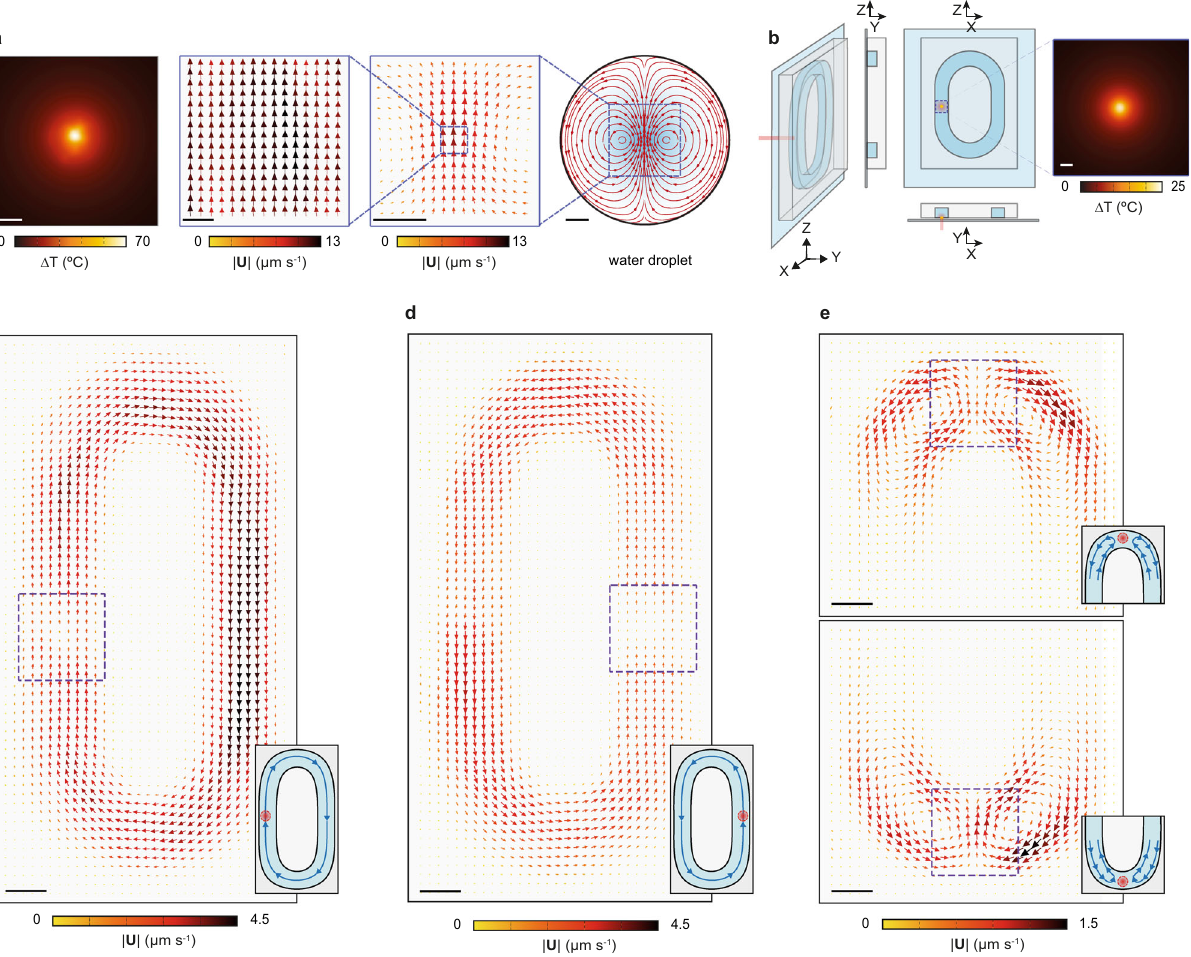
Fig. 6 Long-range fl uid manipulation with a localized thermal gradient. a PIV-based analysis of the convective fl ow induced on a 1.5 mm water droplet by a localized thermal gradient. From left to right: measured steady-state temperature increase in the sample (20 µ m scale bar), resulting velocity map at high magni fi cation (average of 100 frames collected over 20 s, 20 µ m scale bar), and low magni fi cation (average of 100 frames collected over 20 s, 200 µ m scale bar), and simulation of the water droplet and induced convection cells (200 µ m scale bar). b Geometrical representation of the fabricated micro fl uidic device together with the measured steady-state temperature increase over the dashed area (20 µ m scale bar). c Induced fl ow velocity vector fi eld inside the micro channel when plasmonic heating is applied to the left (dashed square, 220 × 220 µ m 2 ), d right and e top and bottom areas of the loop, respectively. (Average of 1000 frames collected over 500 s, 100 µ m scale